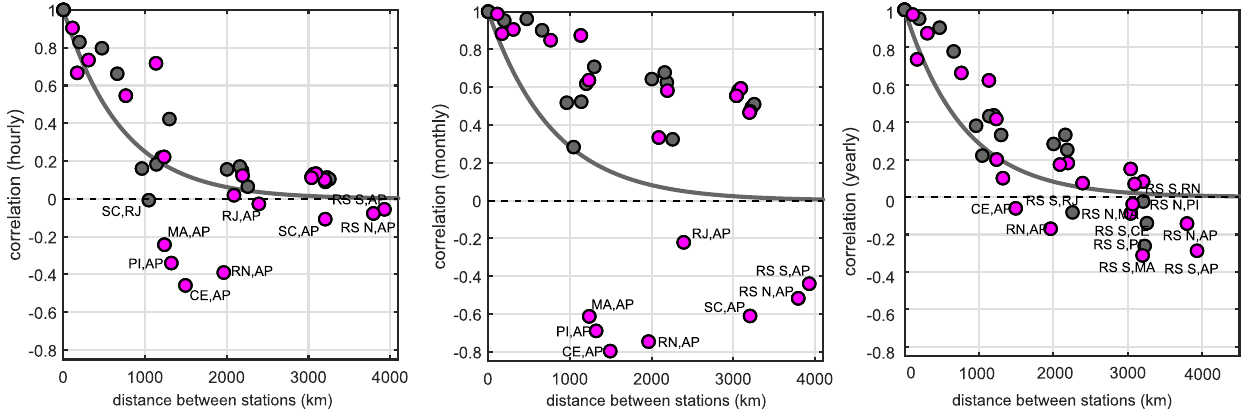
Figure 5. Correlation R between pairs of stations as a function of geographical distance d . The panels illustrate correlation distributions for hourly, monthly, and yearly time series averages (1990–2020).